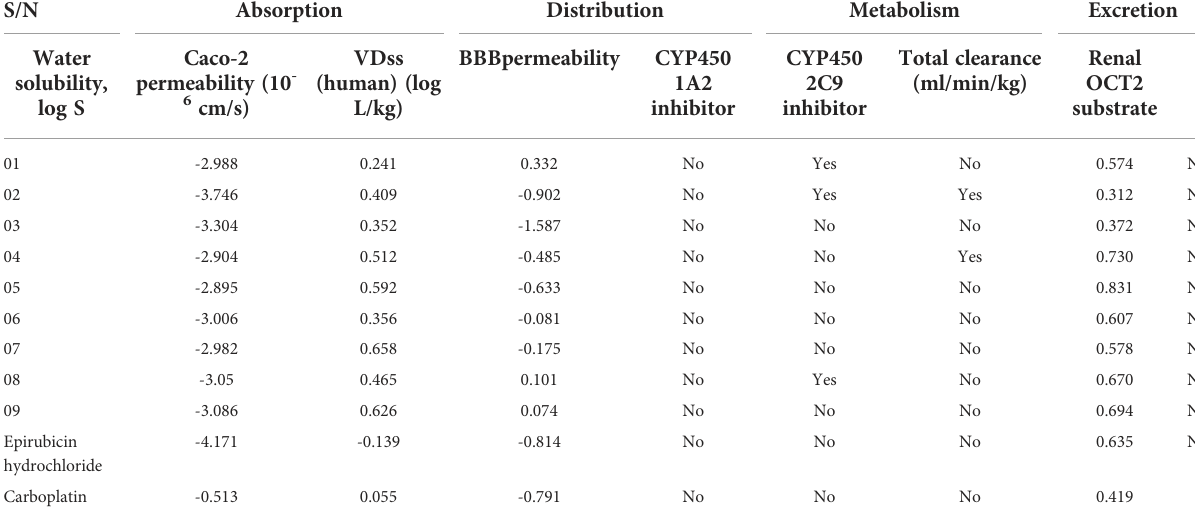
TABLE 4 Computation of ADME features. S/N Absorption